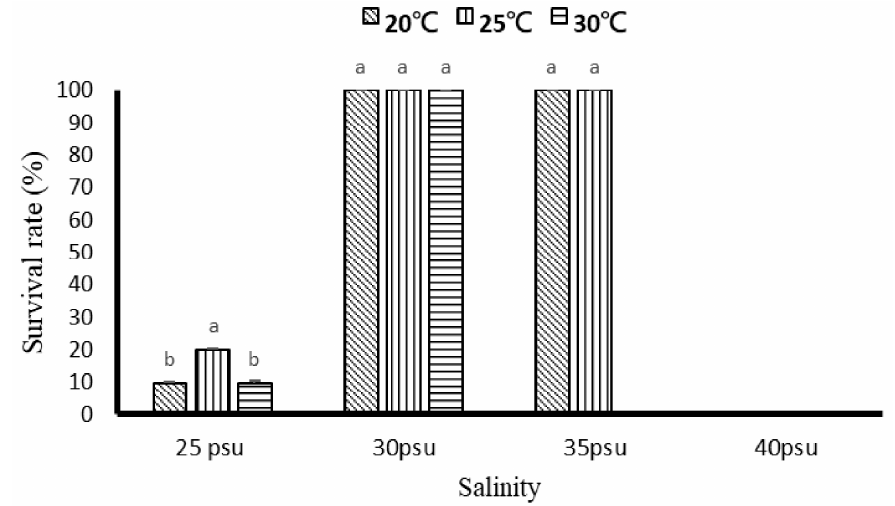
Figure 2. The effect of 8 weeks of different temperature and salinity on the survival of G. columna . Each value represents ± SD ( n = 3). The Latin alphabet represents significant differences ( p < 0.05) in the case of different letters and no difference when the same letter appears.